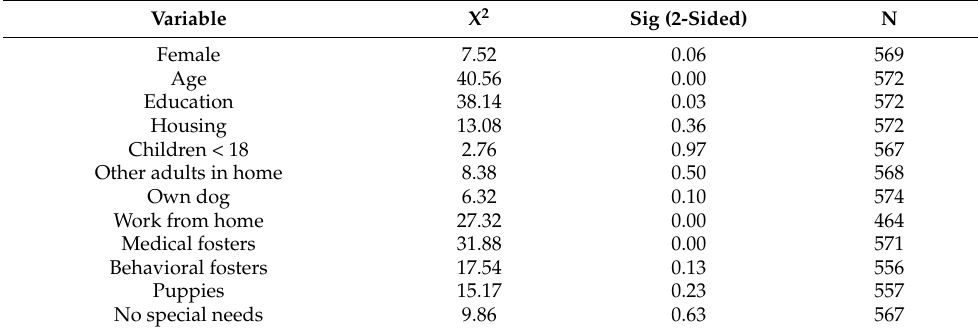
Table 6. Chi Square, volunteer traits and change in service during COVID-19.